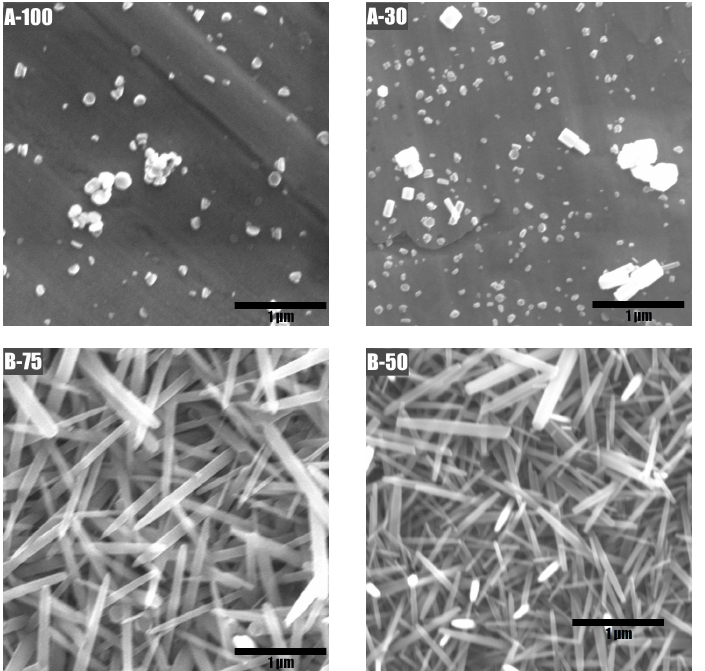
Figure 10. Scanning electron top-view micrographs of sample A-100 (top left), A-30 (top right), B-75 (bottom left), B-50 (bottom right).